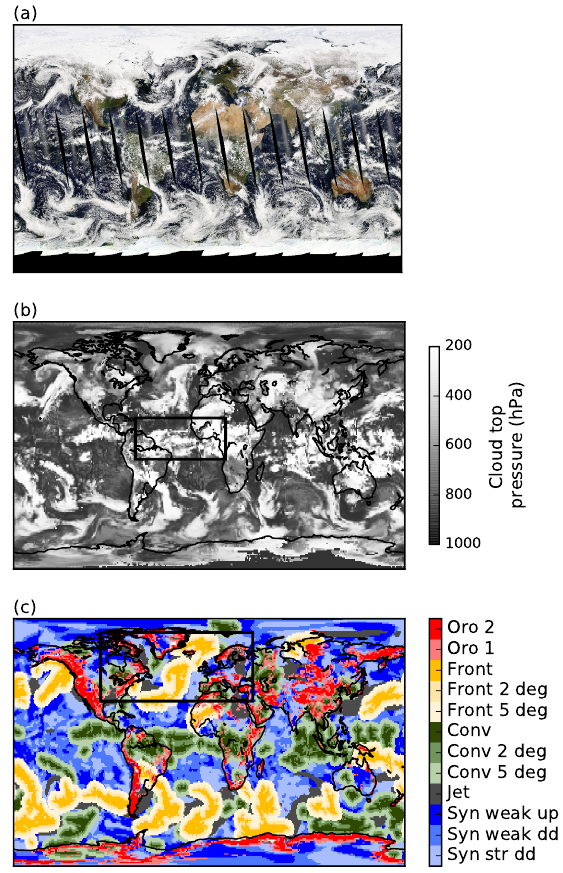
Figure 1. (a) A MODIS Aqua true-colour image for the 12 April 2007. (b) The MODIS daytime cloud top pressure, in-filled with the night-time CTP where no daytime retrieval exists. The box in the tropics shows the location of the regional ICON simulation. (c) The classification presented in this work, derived from MODIS Aqua, ERA Interim and topographic data for the 12 April 2007. The colours denote the classified regime at each point for 13:30LST. The box shows the region where the classification is compared to that from Wernli et al.